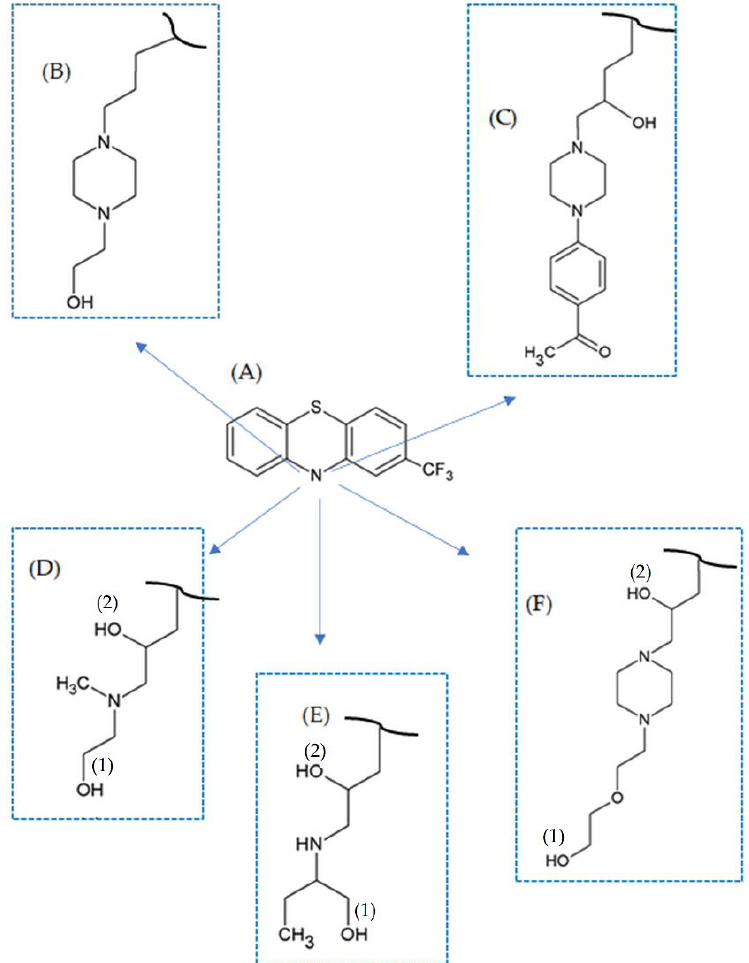
Figure 1. 2-(Trifluoromethyl)phenothiazine, TFMP ( A ), and structure of the side chain for its derivatives: FLU ( B ), APh-FLU ( C ), MAE-TPR ( D ), ABu-TPR ( E ), and HEE-FLU ( F ).